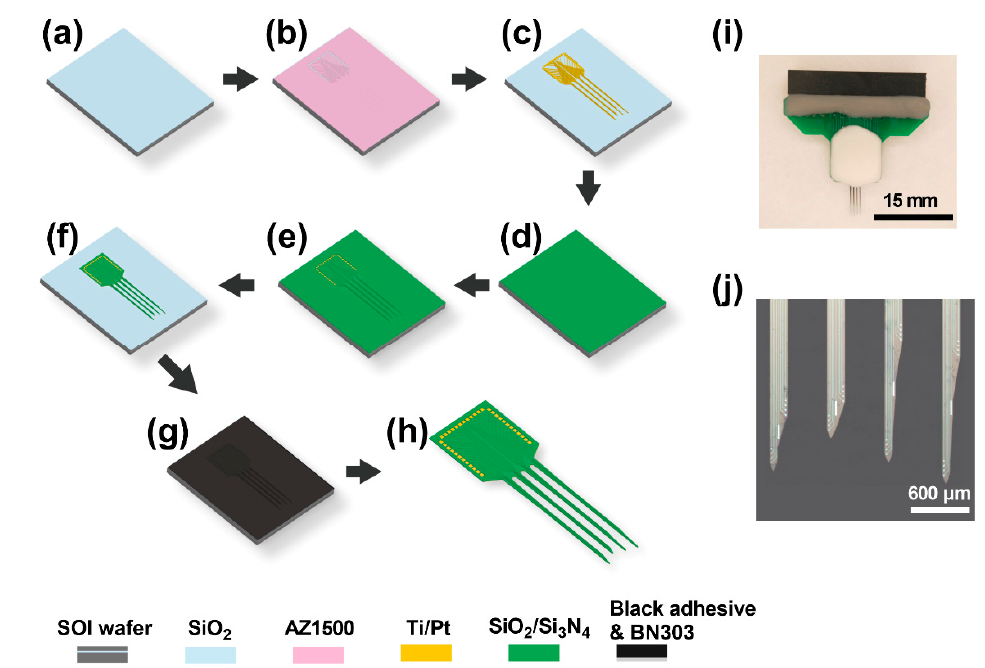
Figure 2. Schematic illustration of the fabrication of the MEA. ( a ) The SiO 2 film was produced by thermal oxidation. ( b ) Spin-coating of photoresist for photoetching the conducting areas. ( c ) Metallization and lift-off of the Ti/Pt conducting layer. ( d ) Deposition of the insulating layer of Si 3 N 4 /SiO 2 . ( e ) Selectively etching of the insulating layer. ( f ) Plasma deep etching. ( g ) Spin-coating of the negative photoresist and black adhesive. ( h ) Release of MEA by back wet etching. ( i ) Packaged MEA. ( j ) Cleaned MEA after ultrasound in acetone.